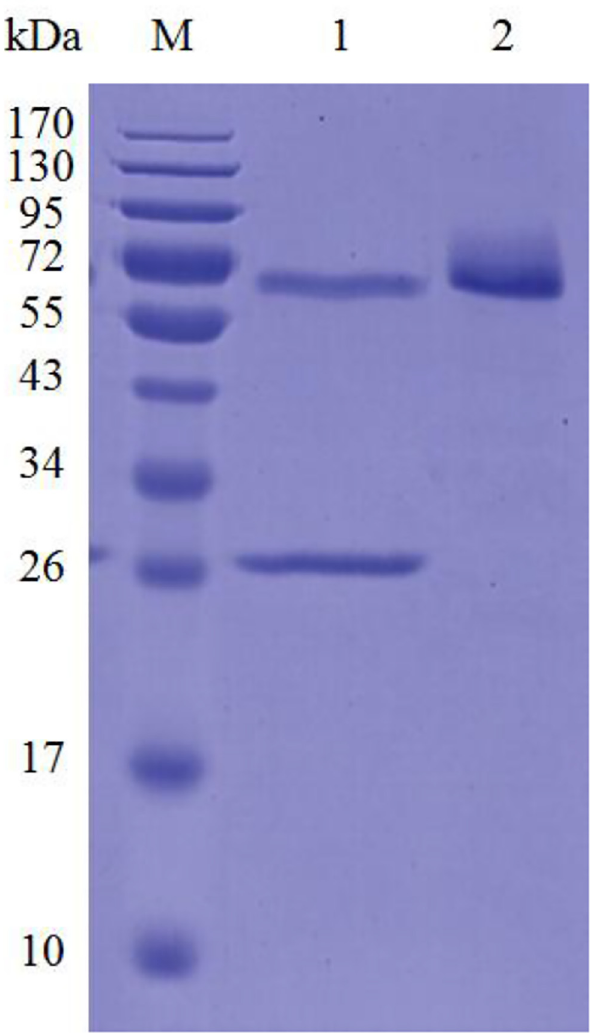
Fig 1. SDS-PAGE analysis of purified recombinant Cel7A. Lanes: M, the molecular mass standards; 1, the deglycosylated Cel7A with Endo H treatment; 2, the purified recombinant Cel7A.